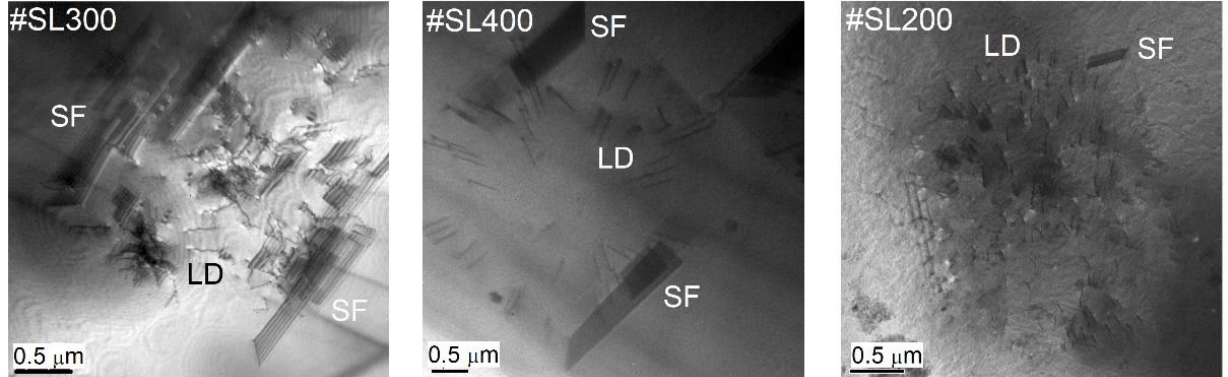
Figure 6. The TEM plan-view images of defect conglomerates consisting of stacking faults (SF) and linear dislocations (LD) for the #SL300, #SL400, and #SL200 structures.